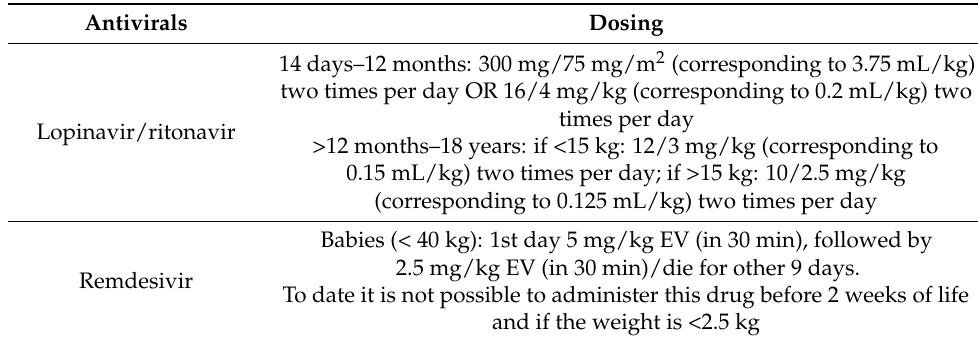
Table 5. Summary of the COVID-19 antiviral dosing [184,186]. Antivirals